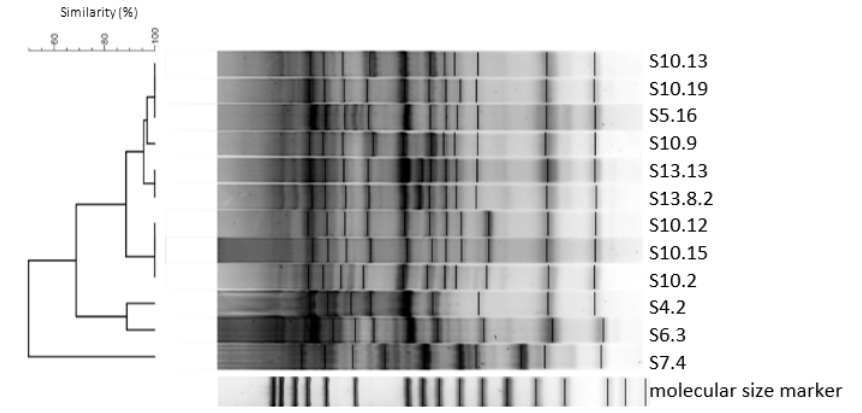
Figure 2. Dendogram based on the cluster analysis of (GTG) 5 -PCR fingerprints from Lactiplantibacillus plantarum isolated from